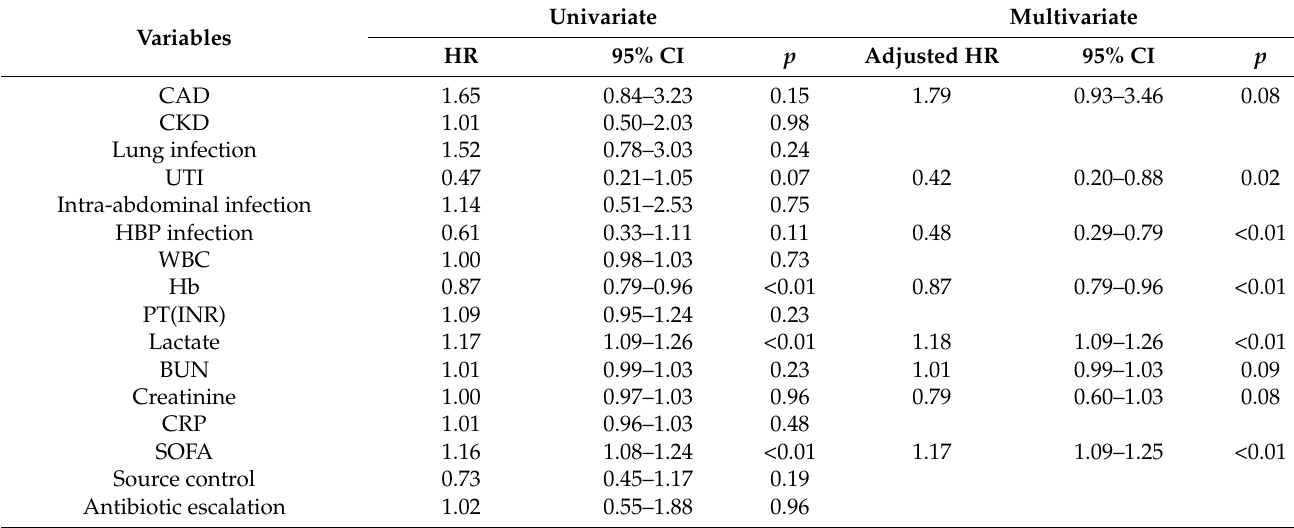
Table 3. Univariate and multivariate analysis for predicting 28-day